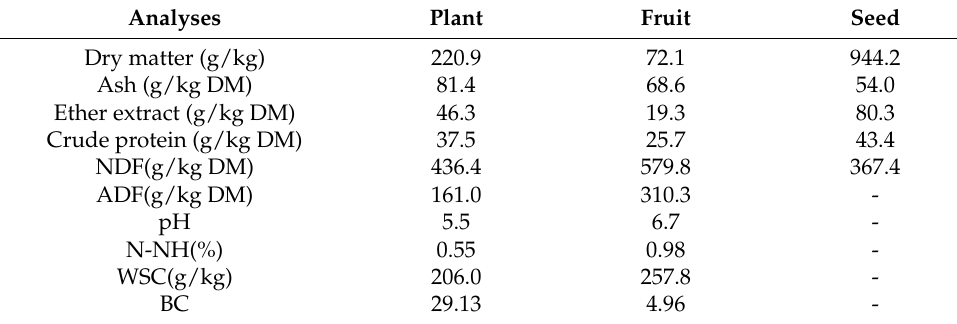
Table 1. Chemical composition of melon biomass before